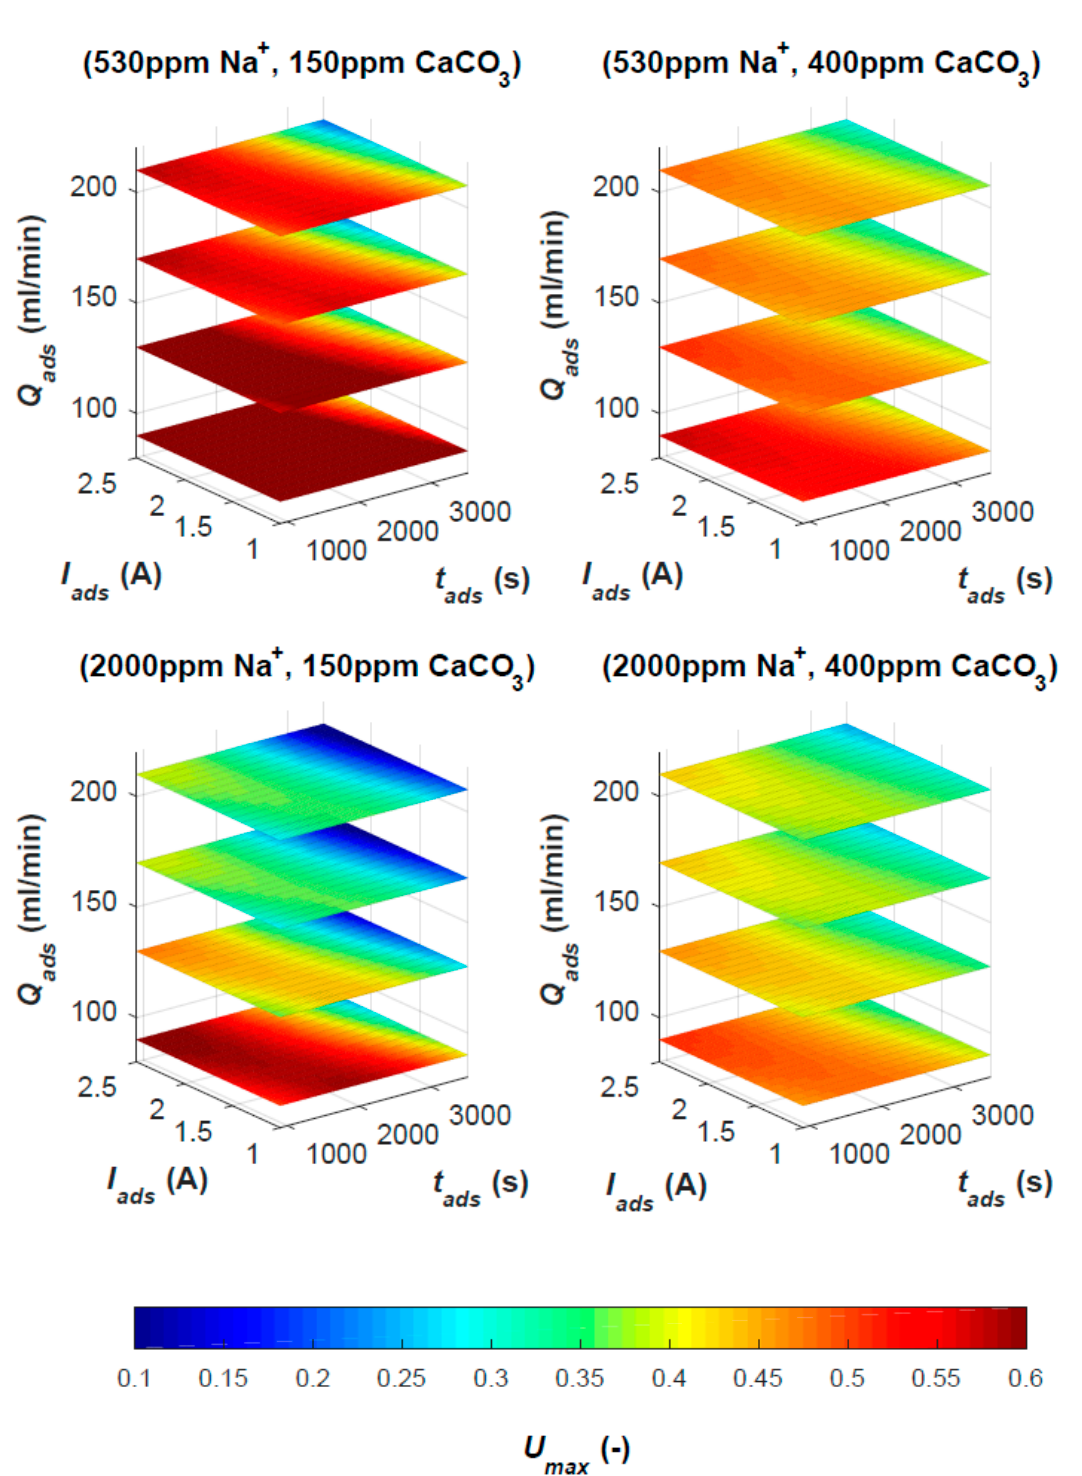
Figure 2. 4D volume plots of maximal utilization ( U max ) for 4 feed water qualities ([Na + ], TH ). U max is given as colormap slices in the volume plot of flowrate ( Q ), current ( I ) and duration ( t ) for MCDI adsorption phase.